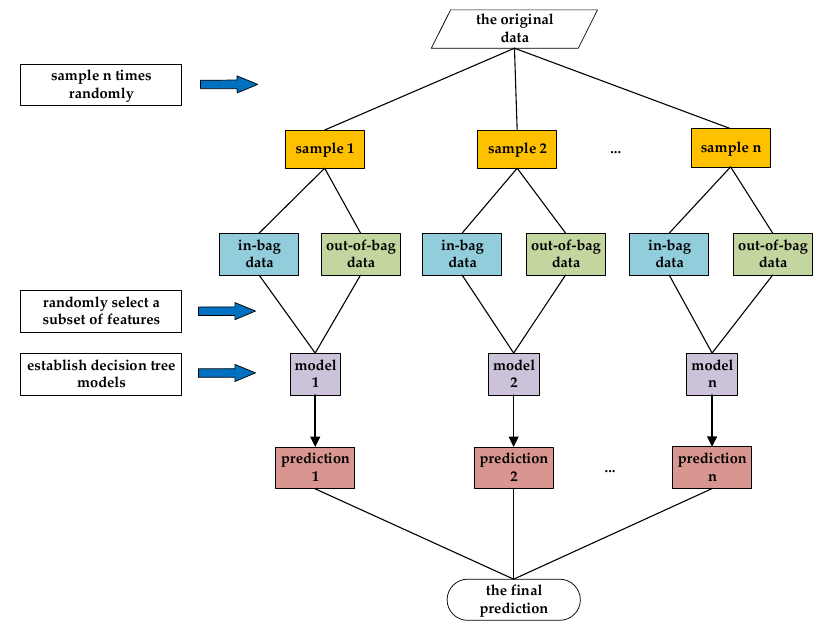
Figure 2. Schematic diagram of random forest prediction structure.